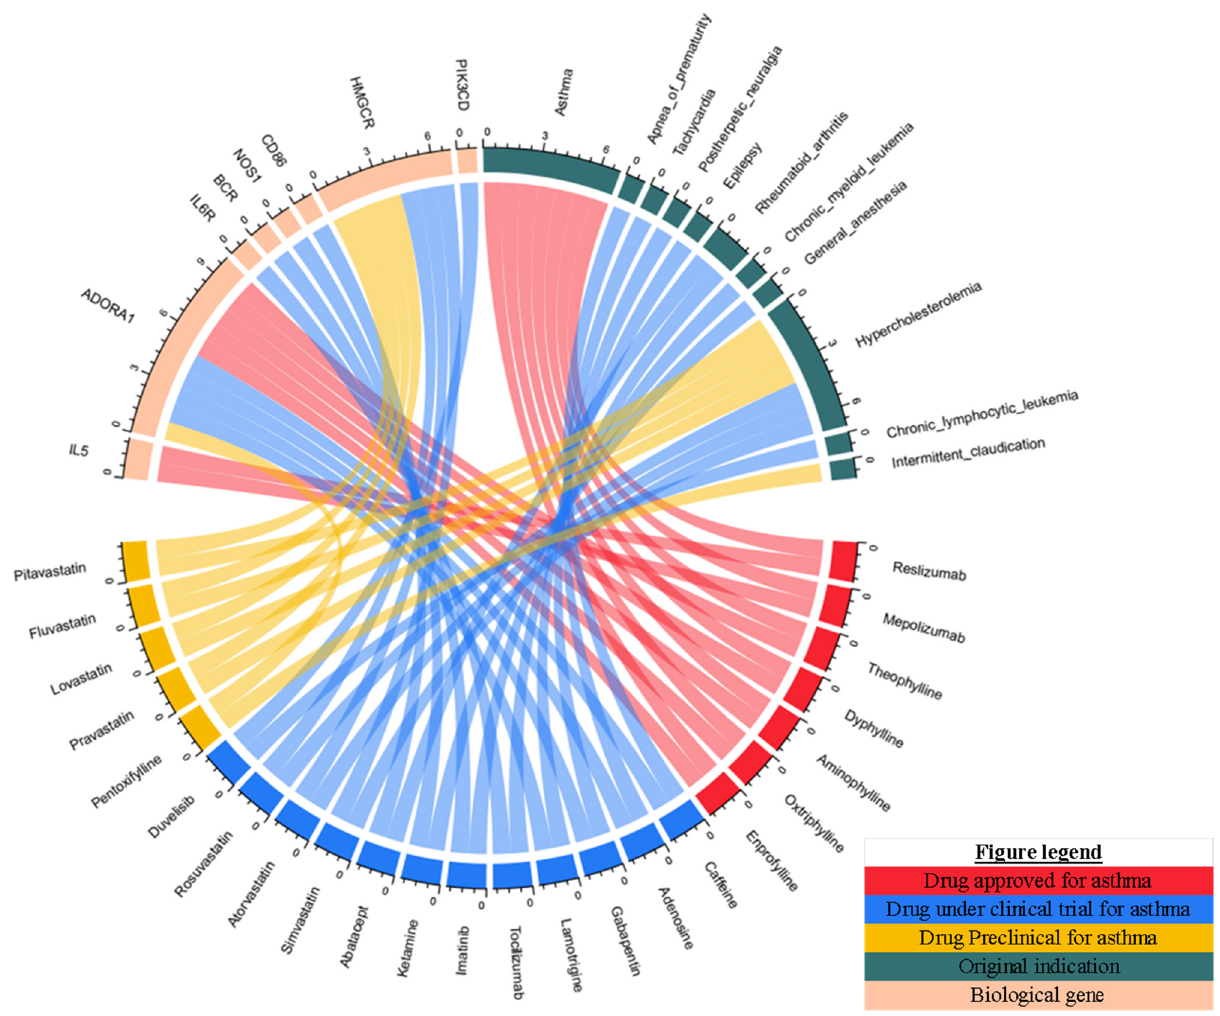
Figure 3. Chord diagram of the connections among biological gene, drug target, and indications identified by clinical trial and PubMed literature review. Table 1. Asthma candidate drugs supported by clinical trials and preclinical